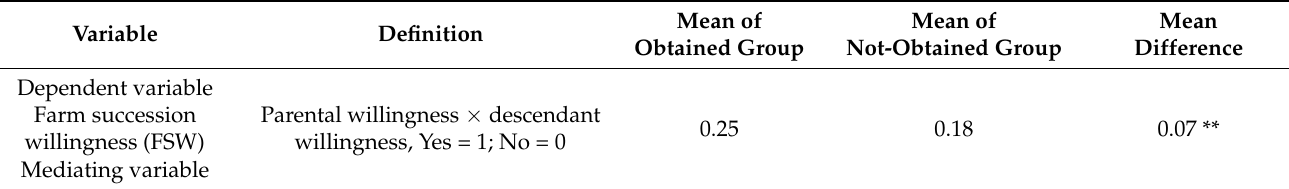
Table 1. Definitions and statistical descriptions of